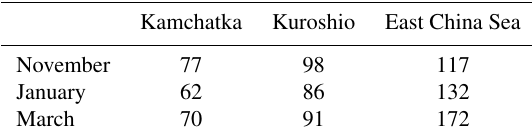
Table 2. Mean lifetime (h) of surface cyclones passing through the northern target region according to their genesis regions.